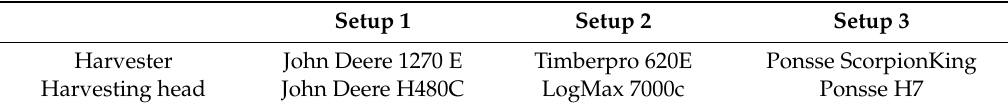
Table 1. Harvesters and harvesting heads